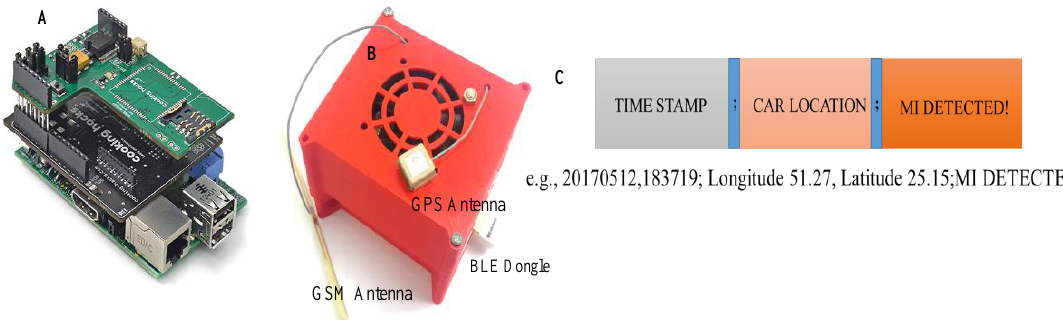
Figure 4 . Intelligent decision-making subsystem hardware ( A ) with the 3D printed model ( B ) and the packet format used for communication ( C ).